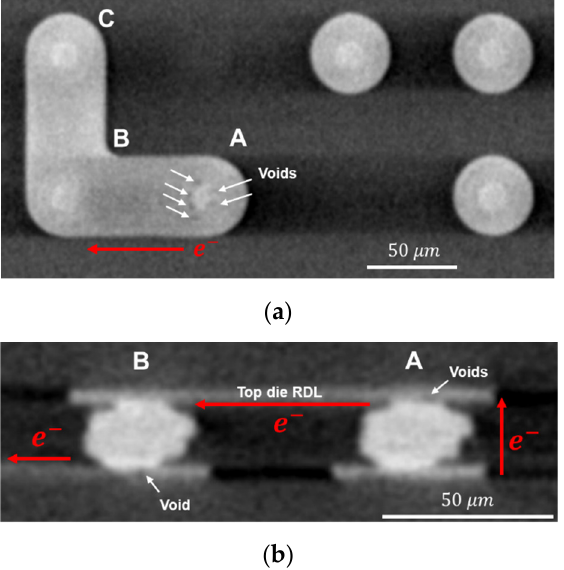
Figure 6. Nondestructive observation of 90 MPa/30 s_K3 bumps. ( a ) Computed tomography of the top die RDL. The voids form at the top die RDL of Kelvin bump A. ( b ) Computed tomography of the cross-section along the current direction in Kelvin bumps. The voids are observed at the top die RDL of Kelvin bump A and at the bottom die RDL of Kelvin bump B.